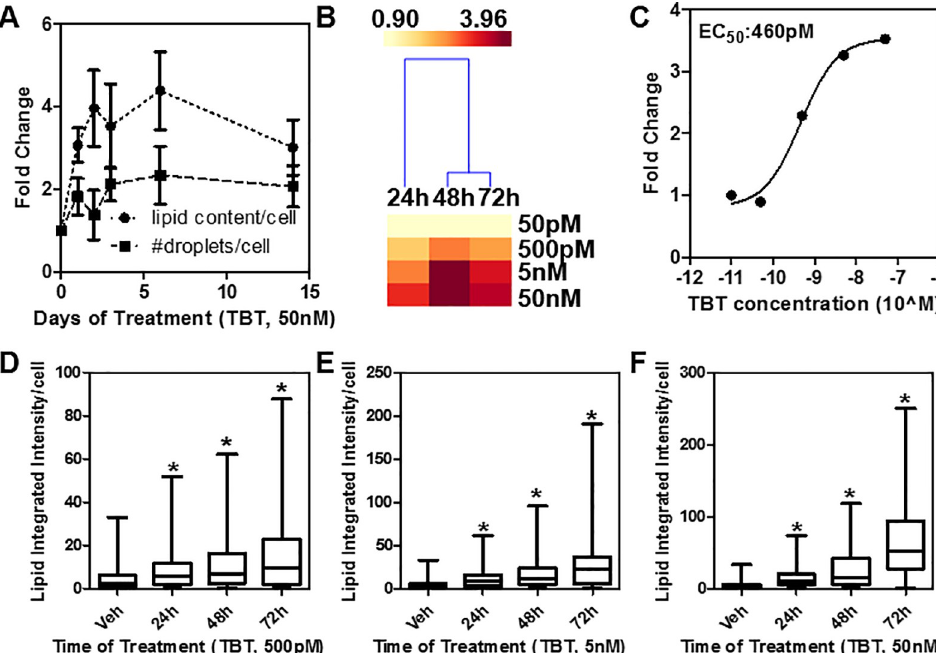
Fig 2. TBT increases lipid content in a time- and dose-dependent manner in HepaRG cells. A) HepaRG cells were grown in the presence of TBT (50 nM) or vehicle for 1 to 14 days and lipid droplets were stained with LipidTox. Y axis is fold change over DMSO treated cells. B) heatmap showing total lipid content/cell after treatment with TBT (50 pM-50 nM) for 1 to 3 days. C) dose-response curve and EC 50 calculation at the 72 hr time point. D-F) box plots representing single cell data from panel B. � p < 0.05 by ANOVA (Kruskal-Wallis